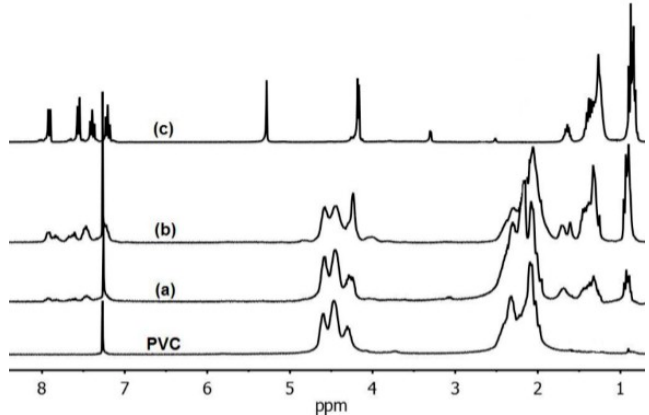
Figure 1. Series of 1 H–NMR spectra of PVC modified with ( a ) 20 wt % and ( b ) 40 wt % of compound oE ; and ( c ) shows the spectrum of pure oE .